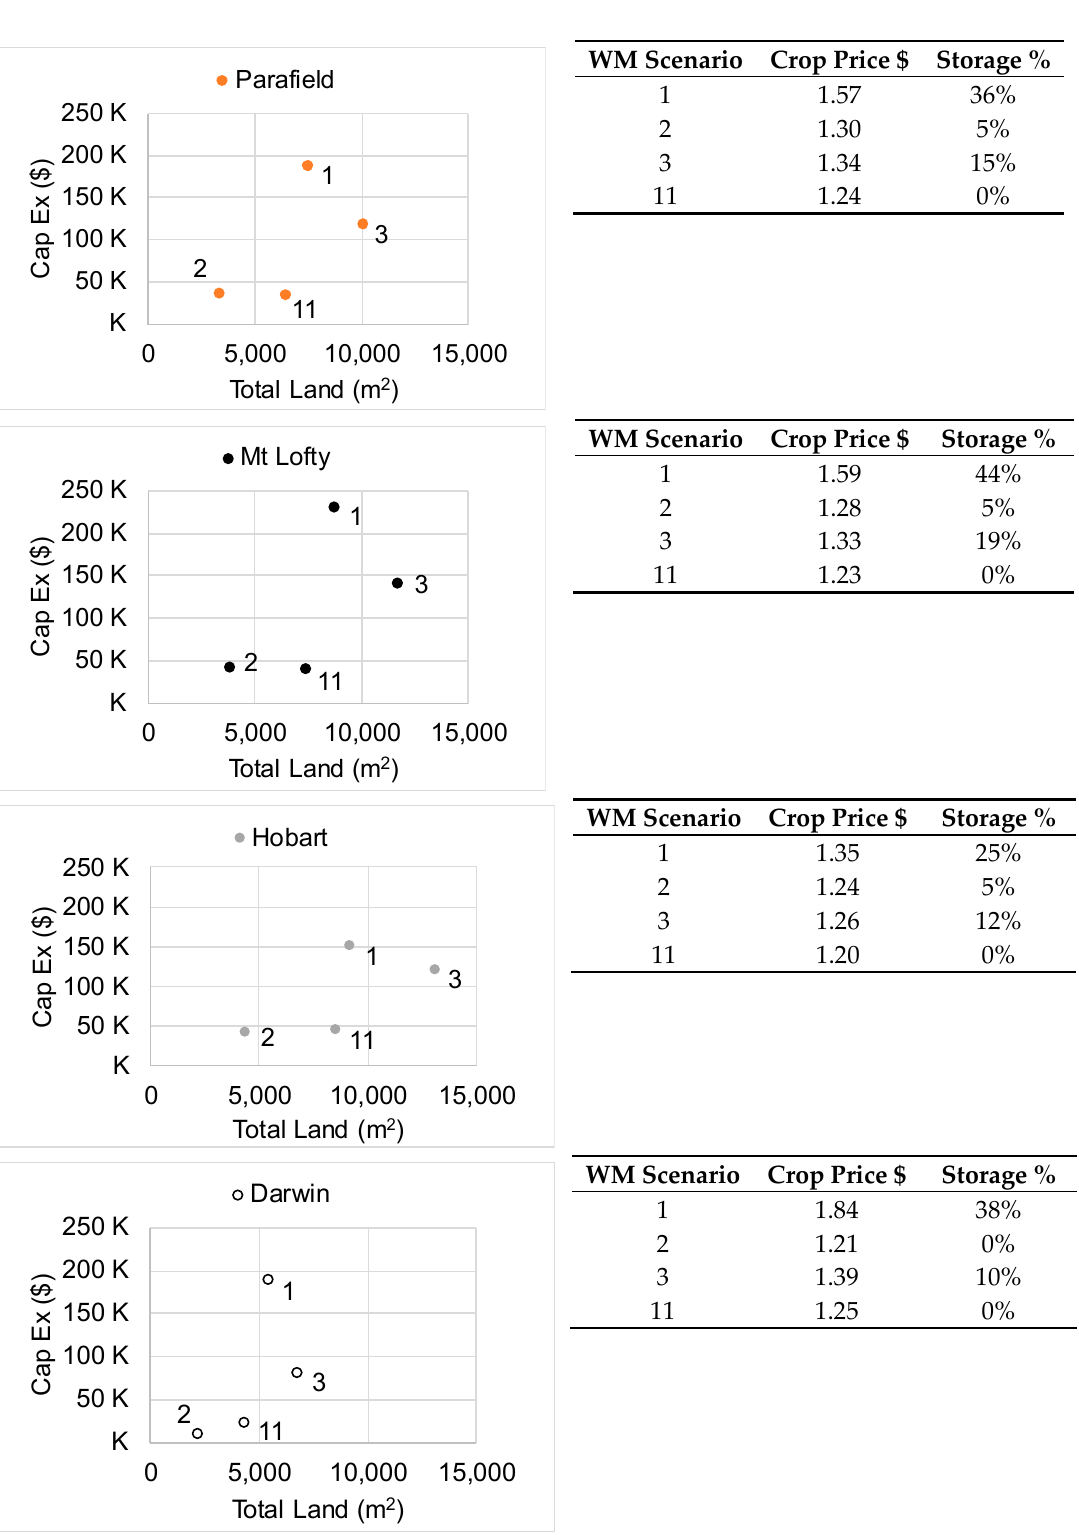
Figure 12. Soil-based reuse in field conditions (SOIL-FIELD) across four Australian climates.